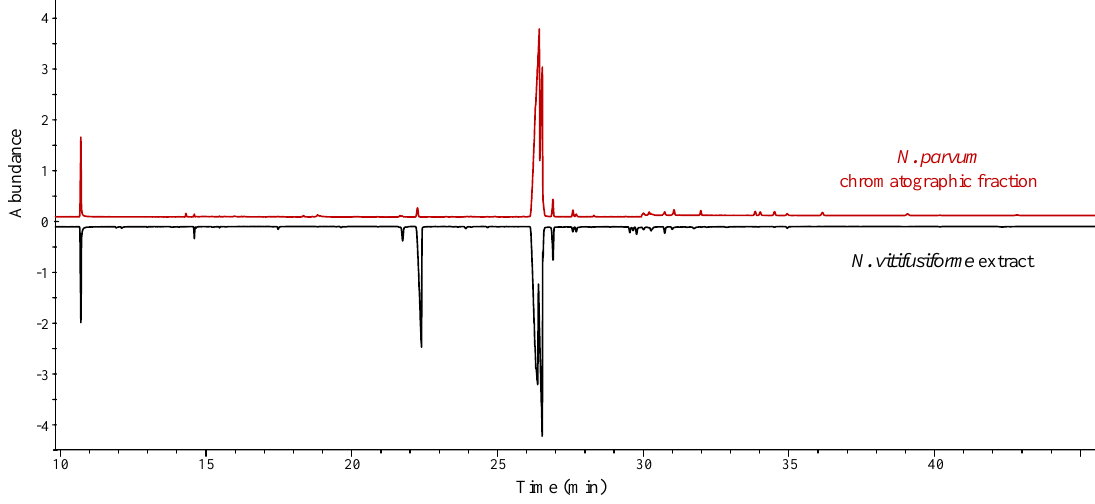
Figure 2. Head to tail comparison of total ion chromatogram (TIC) profiles of methylated compounds from N. parvum (chromatographic fraction) and N. vitifusiforme (crude extract). For clarity, chromatograms have been translated in the vertical direction by an arbitrary amount.